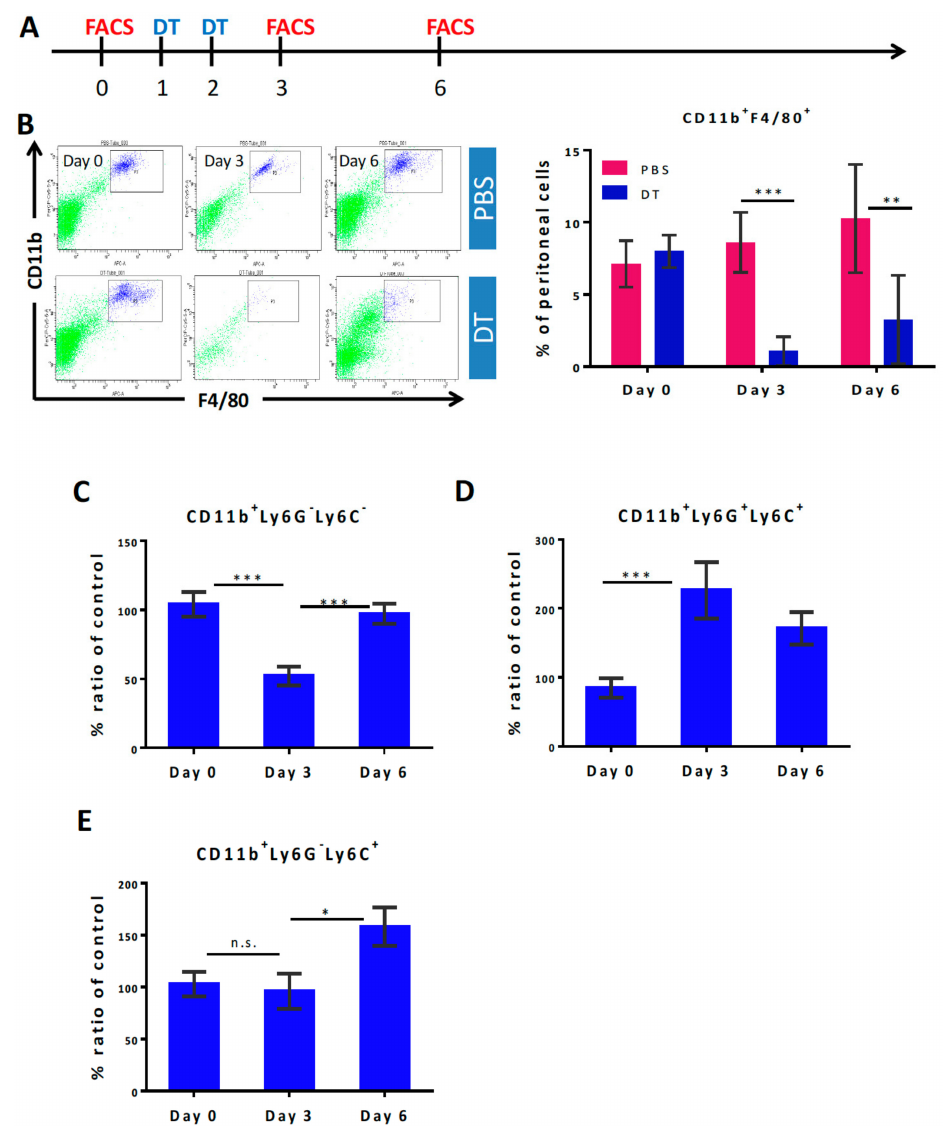
Figure 1. Selective myeloid cell depletion in transgenic CD11b-DTR mice ( A ) The timeline of DT administration and flow cytometry analysis (FACS) on lysed blood cells. ( B ) Representative flow cytometry images of peritoneal cells gated by CD11b and F4 / 80 and the change in percentage of CD11b + F4 / 80 + peritoneal macrophages following the DT treatment at the indicated times ( n ≥ 3 for each group). ( C – E ) Changes in myeloid subgroups in lysed blood stained with Ly6G and Ly6C antibodies and analyzed by flow cytometry ( n ≥ 10 for each group). Statistics were performed using one-way ANOVA by GraphPad Prism 5. *, p < 0.05; **, p < 0.01; ***, p < 0.001; n.s., p >